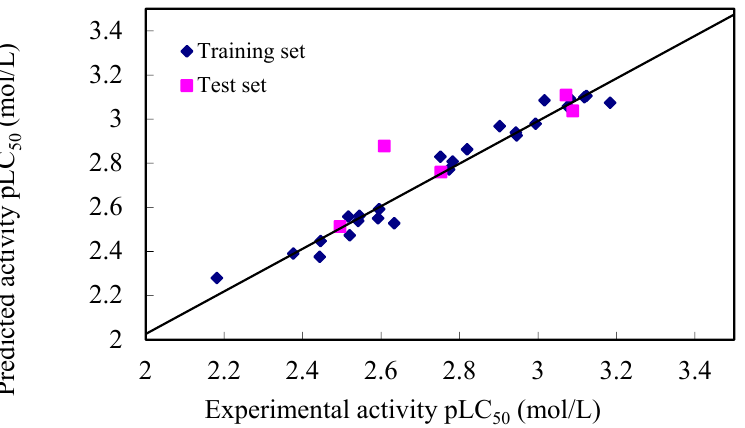
Figure 3. The plot of experimental versus calculated pLC 50 values from CoMSIA analyses for the training and test set compounds.